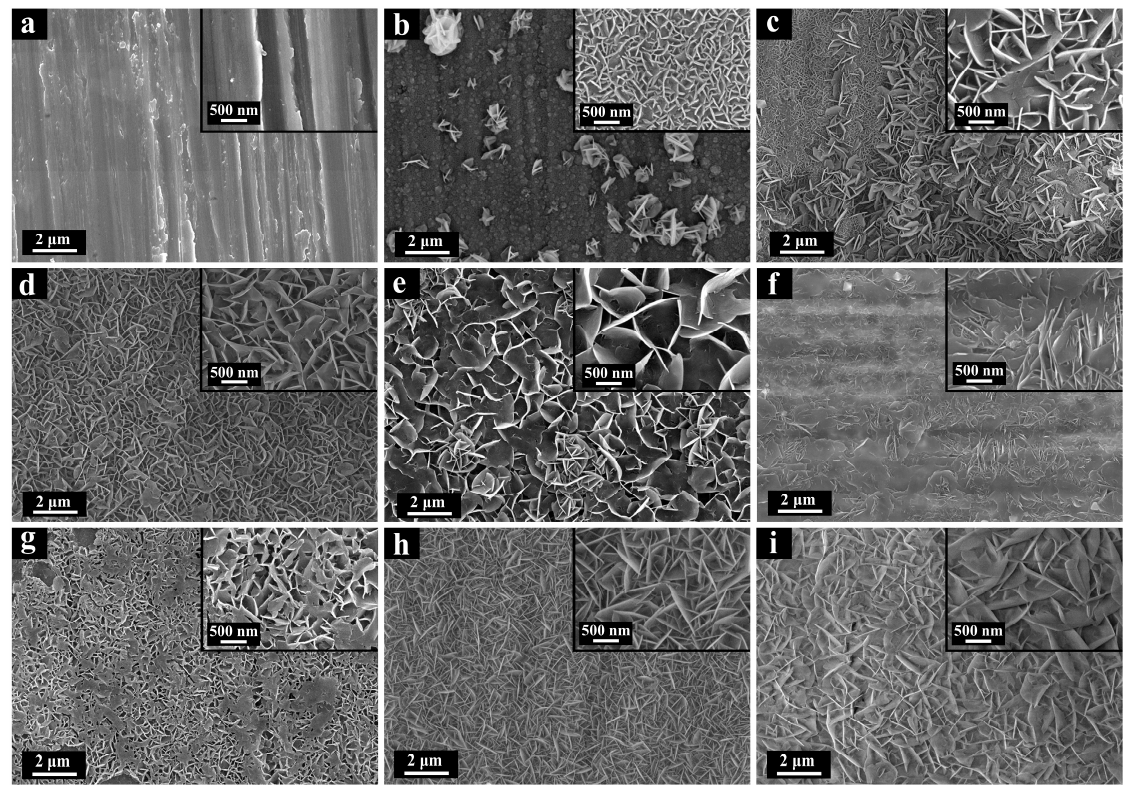
Figure 1. SEM images of surface morphology of samples. ( a ) CoCrFeNiMo ‐ HEA. ( b ) LDHs ‐ 0.1 M ‐